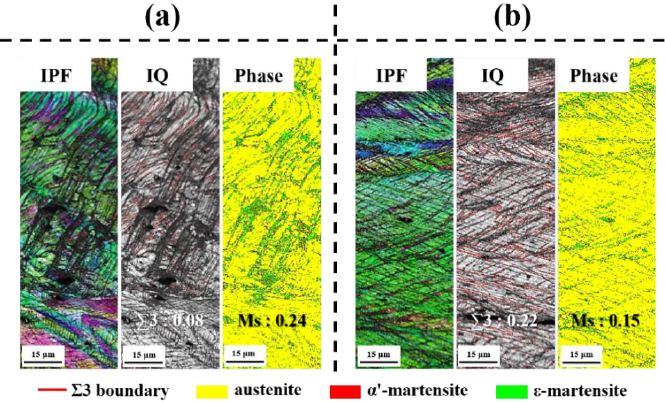
Figure 8. Microstructures near the tensile fracture position tested at 289 K in each weld: ( a ) using STS 308L filler and ( b ) HEA filler.